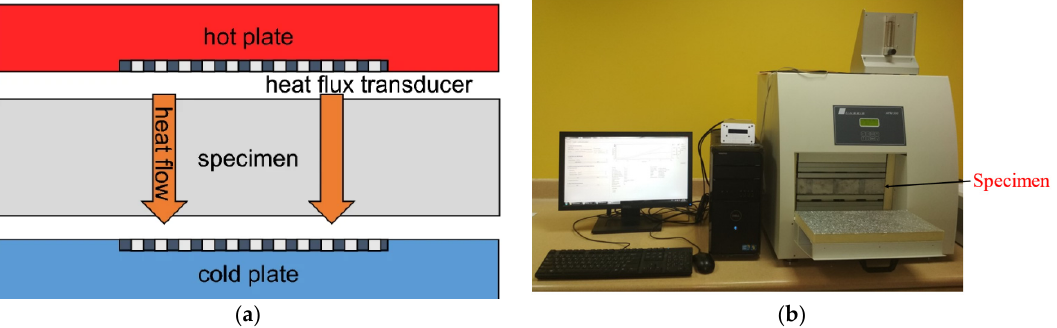
Figure 1. Thermal conductivity experimental setup: ( a ) schematic view; ( b ) pictorial view.